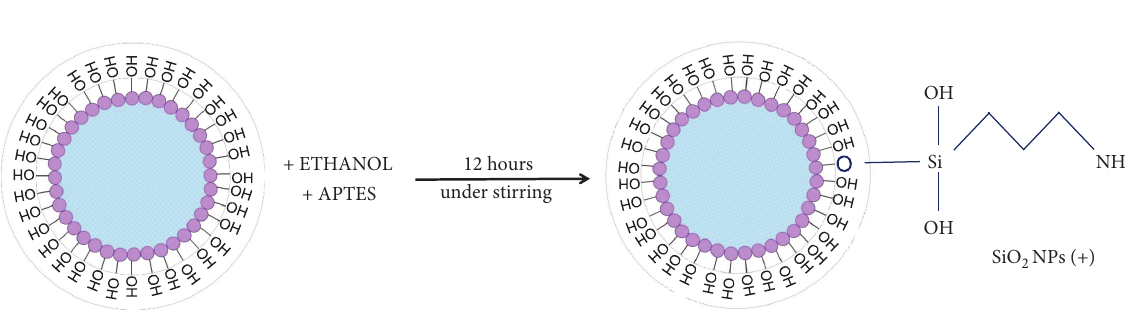
Figure 2: Schematic representation of SiO